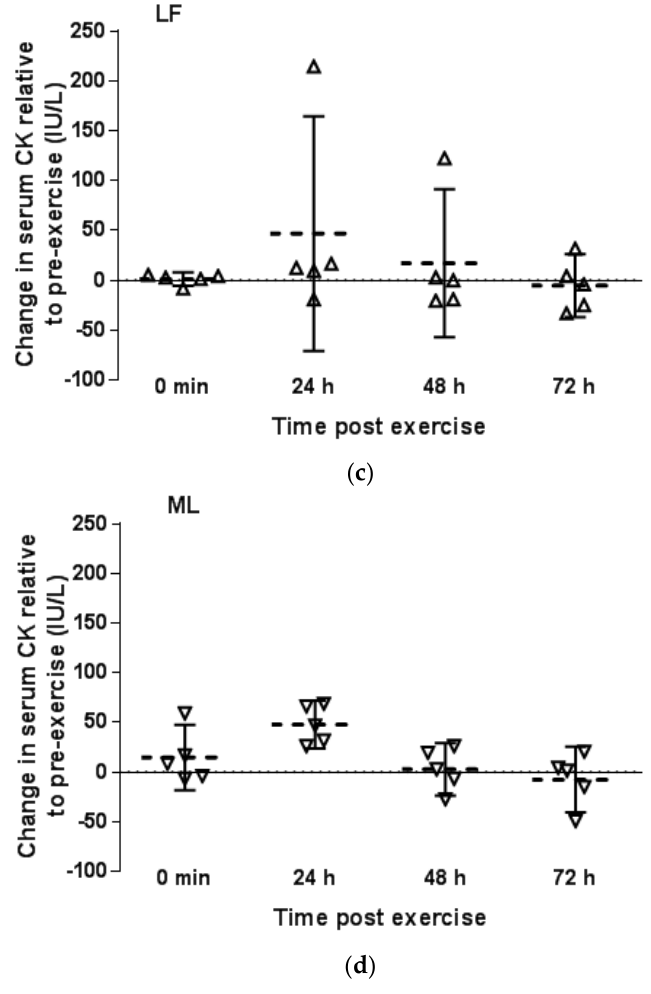
Figure 2. Menstrual phase comparison of the absolute serum creatine kinase (CK) activity pre- and post downhill running expressed as mean ± SD ( a ); and the magnitude of CK response post downhill running showing the individual data and average (---) change relative to pre- exercise and 95% confidence interval for early follicular (EF) group ( b ); late follicular (LF) group ( c ) and mid-luteal (ML) group ( d ). # and ### denotes a significant difference relative to pre- exercise (−20 min ) within a group, p < 0.05 and p < 0.001, respectively.